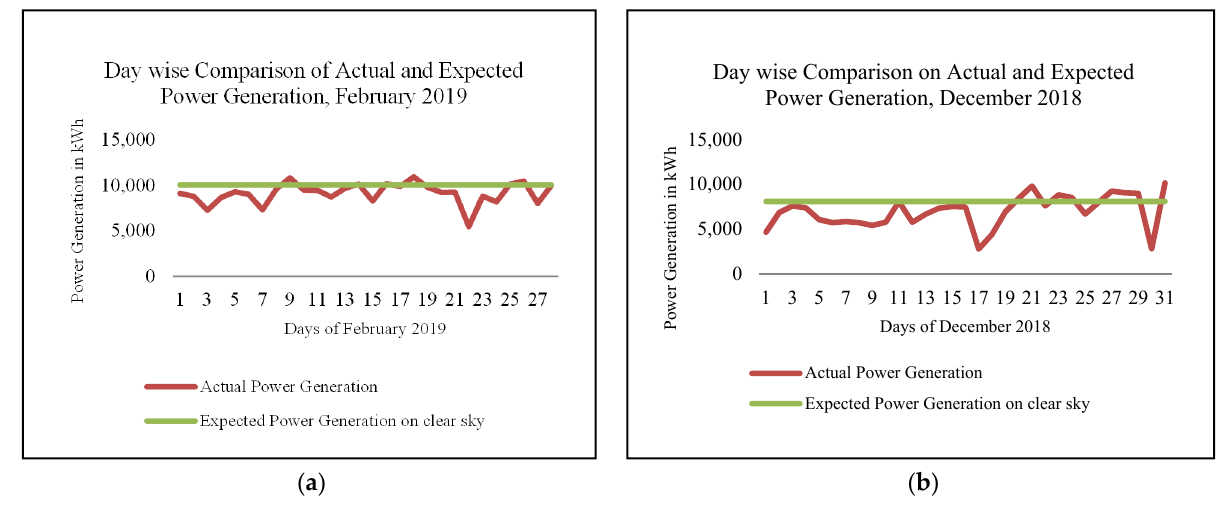
Figure 2. ( a ) Actual versus Expected Solar power generation of February 2019. ( b ) Actual versus Expected Solar power generation of December 2018 .